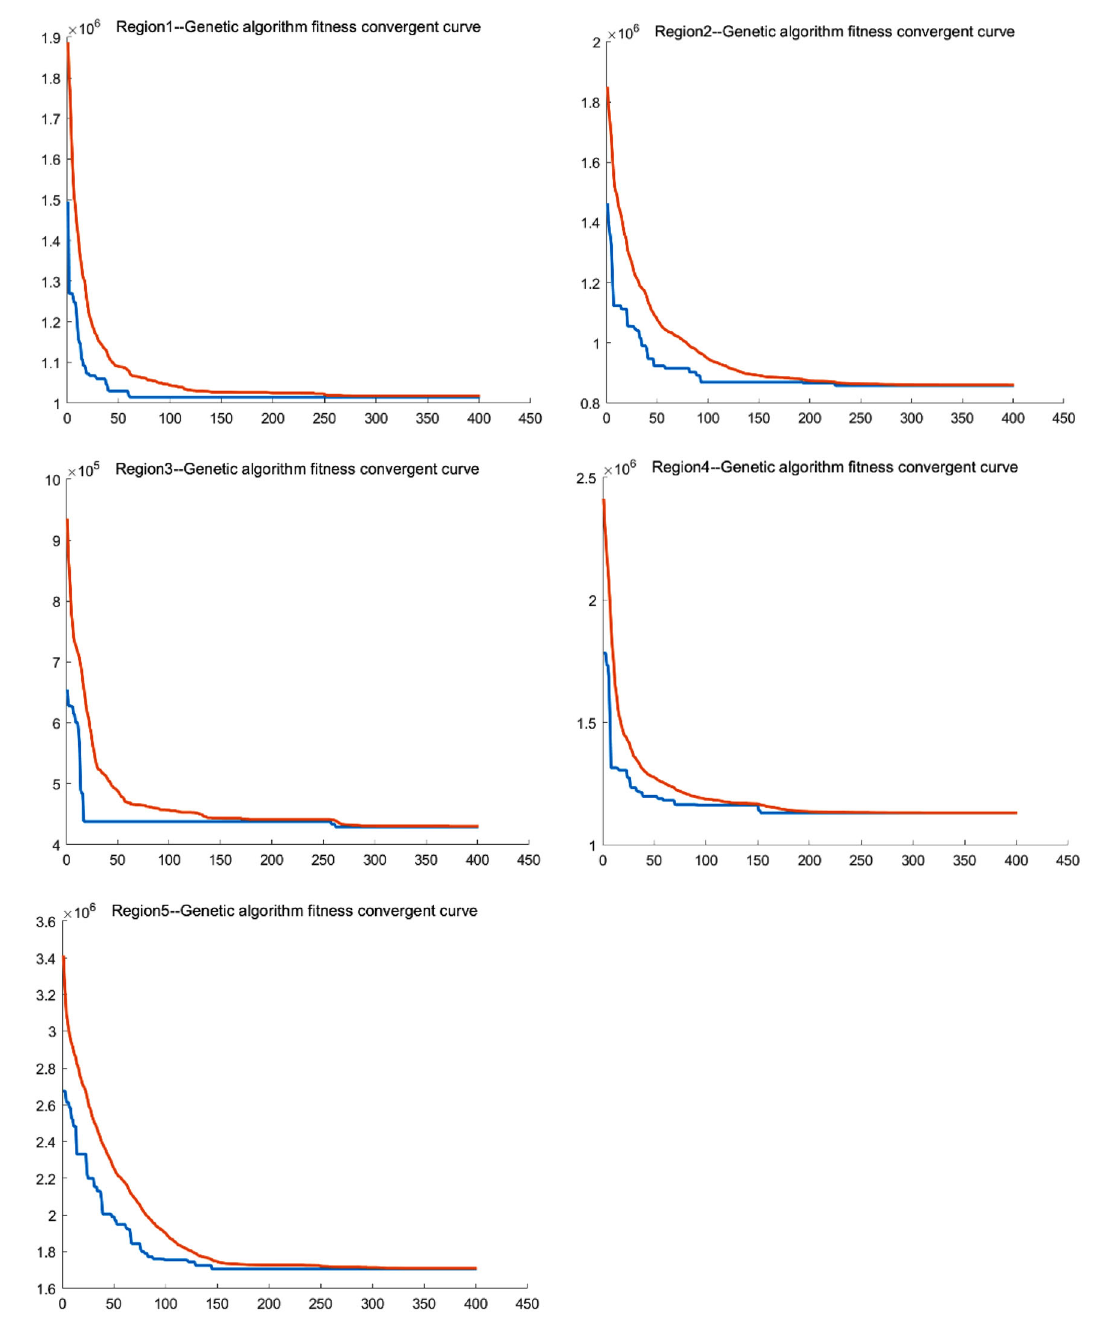
Fig. 7 Convergent curve for each